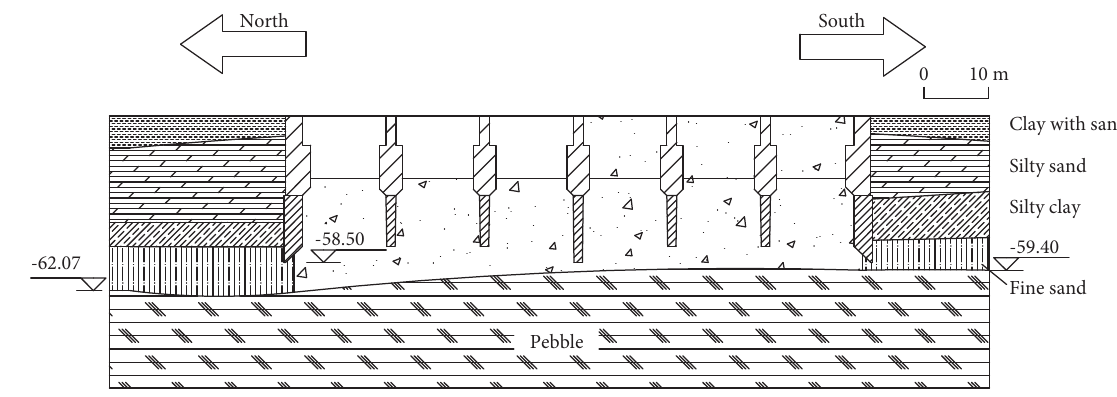
Figure 4: The stratigraphic distribution under south anchorage (unit: